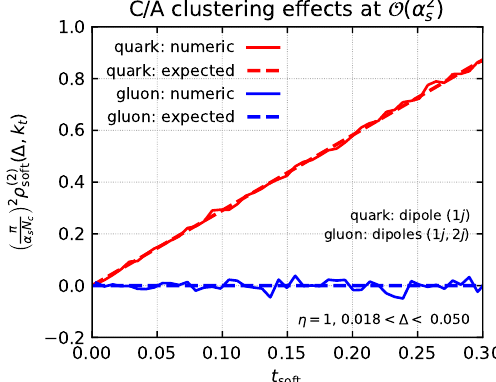
(a) E(cid:11)ects of soft gluon radiation at large angles for di(cid:11)erent dipole con(cid:12)gurations (including or not the jet).